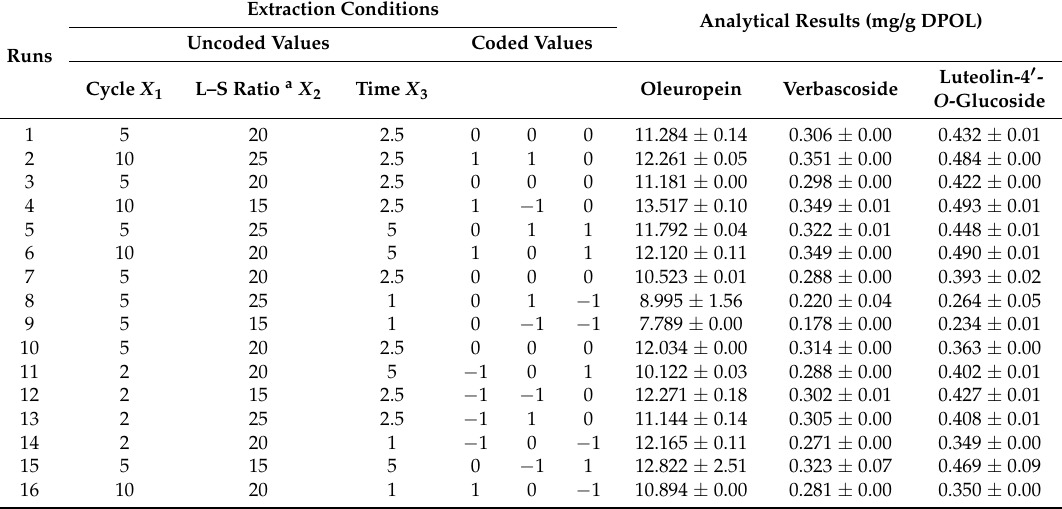
Table 1. Experimental design in coded and uncoded form, and values of experimental data (yields of oleuropein (OLE), verbascoside (VER), and luteolin-4 (cid:48) - O -glucoside (L4OG)) using the Box–Behnken design (BBD) matrix. DPOL—dry powdered olive